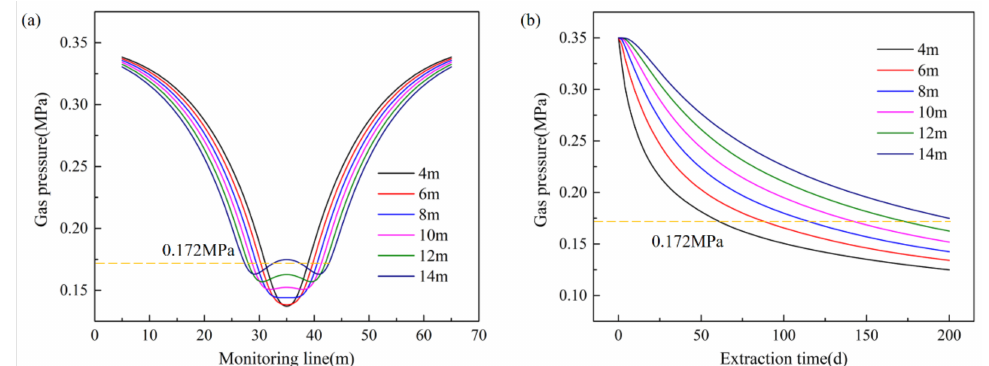
Figure 25. Monitoring data of gas pressure of monitoring line and monitoring point. ( a ) Variation law of gas pressure with monitoring line at different borehole spacing. ( b ) The law of gas pressure variation with time with two boreholes.